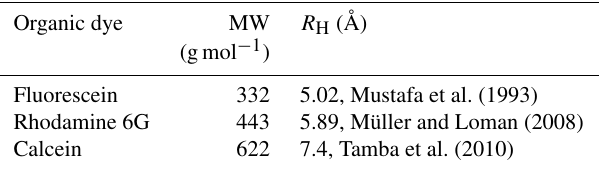
Table 1. The molecular weight (MW) and hydrodynamic radius ( R H ) of the fluorescent organic dyes used in this work. Organic dye